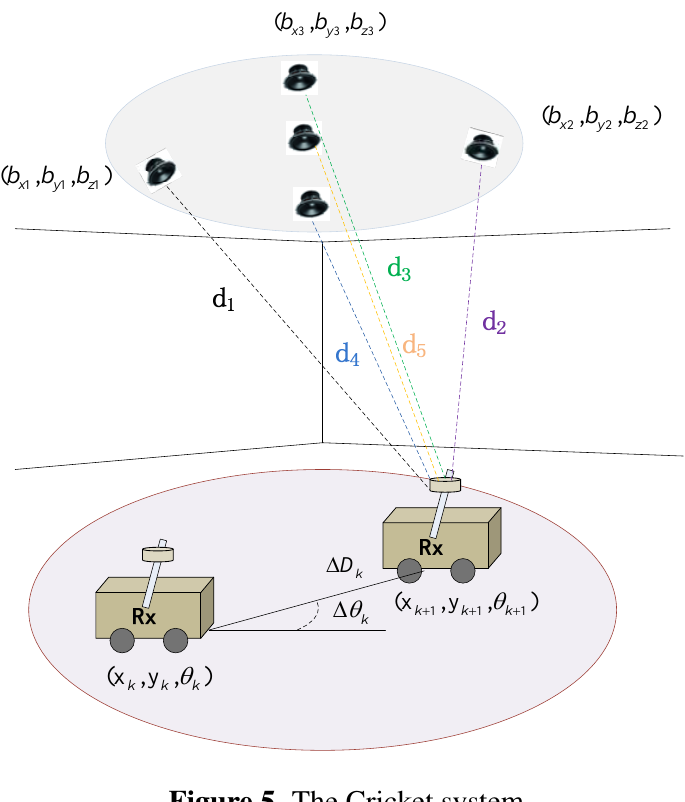
Figure 5. The Cricket